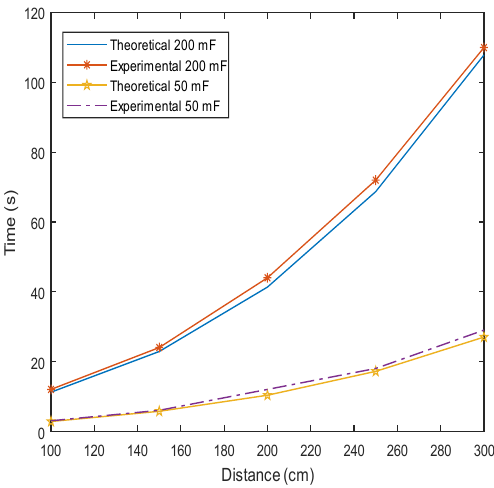
Figure 9. The charging time duration for 50-mF and 200-mF supercapacitors increases exponentially